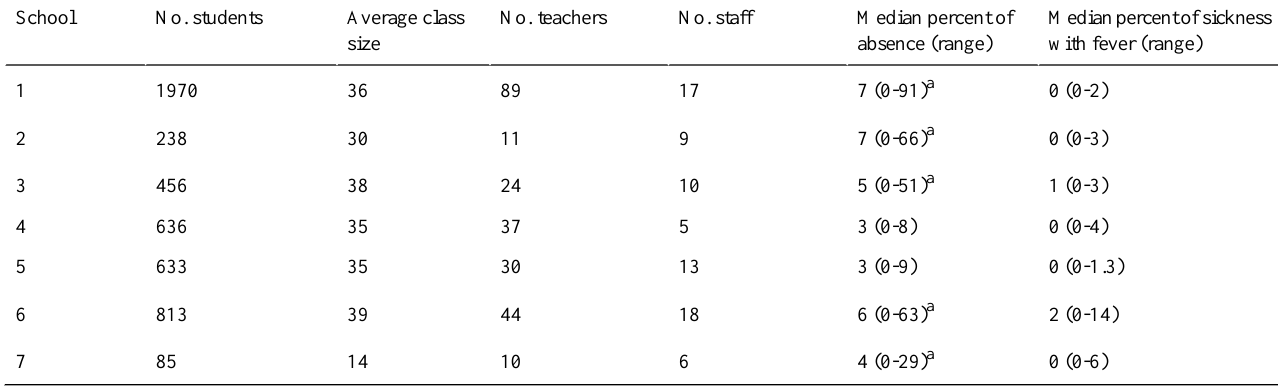
Table 1. Characteristics of the 7 participating